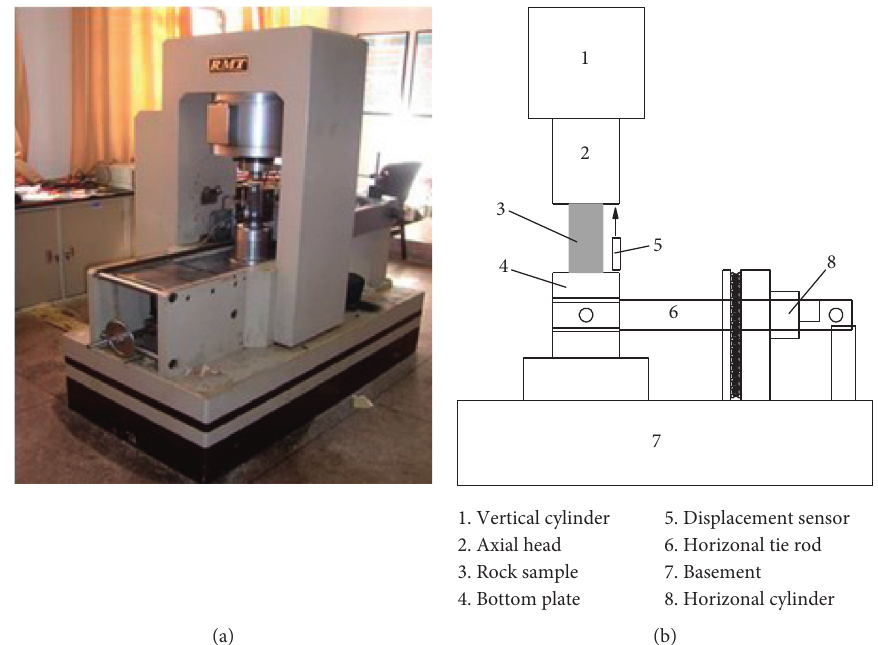
Figure 3: Electrohydraulic servo rock test system of RMT-150B. (a) Test system. (b) Schematic diagram of uniaxial compression.